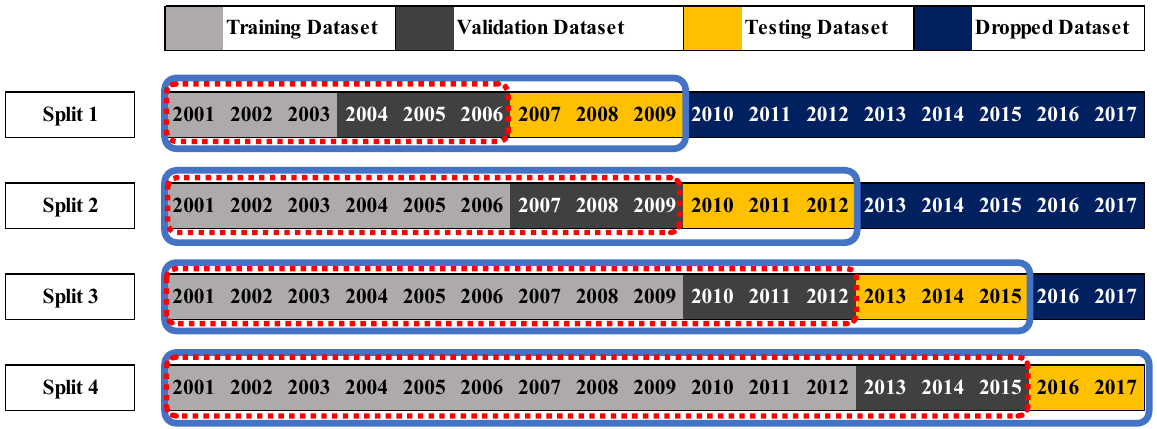
Figure 4. Nested cross validation (expanding window approach).